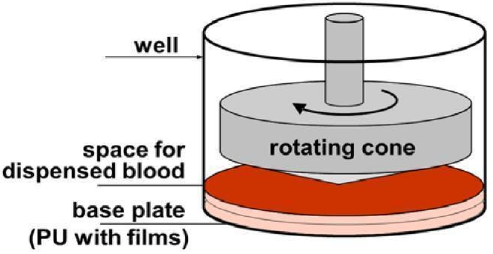
Figure 3. Schematic of Impact-R test [61] (copyright permission has been provided).